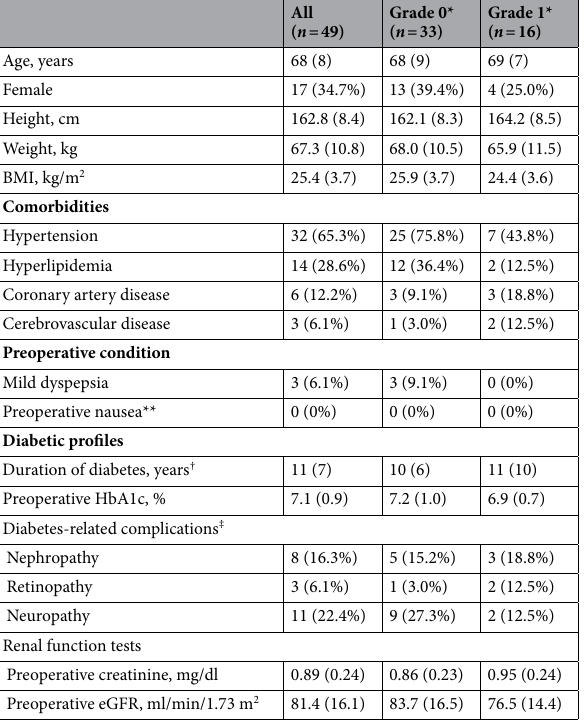
Table 1. Patient demographics and baseline characteristics. Data are presented as mean (SD), or number (%). BMI, body mass index; eGFR, estimated glomerular filtration rate; HbA1c, Hemoglobin A1c. *The grades were defined as ‘antral grading system’ based on ultrasound assessment of gastric content and volume depending on position; grade 0—the antrum appeared empty on both supine and right lateral decubitus positions; grade 1—gastric fluid was visible on the right lateral decubitus position only, suggesting a small fluid volume. **Two missing values in the grade 0 patients. † Four missing values in the grade 0 patients. ‡ Defined as patients who have been diagnosed with diabetes-related